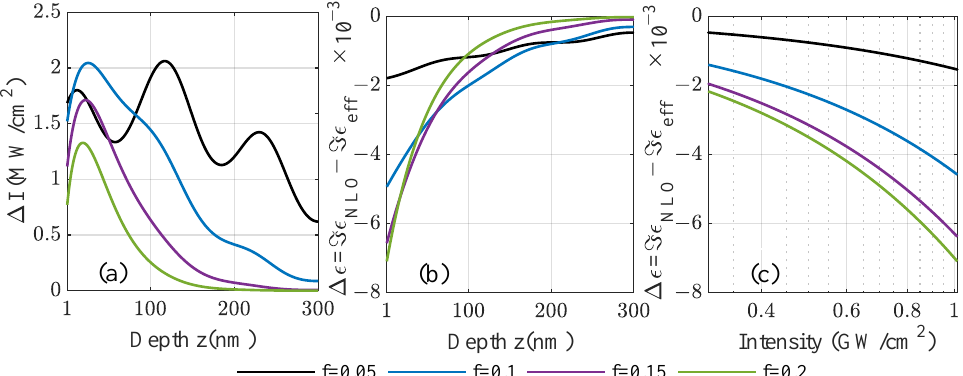
Figure 6. For amorphous composites with varying fill factors of iridium inclusions using the analytic case based on Miller’s rule, the ( a ) change in total intensity (forward and backward scattering contributions) ∆ I = I NLO − I lin is shown at incident frequency ω = 4.6 eV below the related Mie resonance. From the intensity, the change in the imaginary part of the local nonlinear permittivity ∆ Im (cid:101) = Im (cid:101) − Im (cid:101) NLO eff is calculated as a function of ( b ) the position inside a 300 nm film. The incident power density is 1.6 GW / cm 2 . In ( c ), the change in the modified nonlinear permittivity is studied as a function of incident power, demonstrating induced